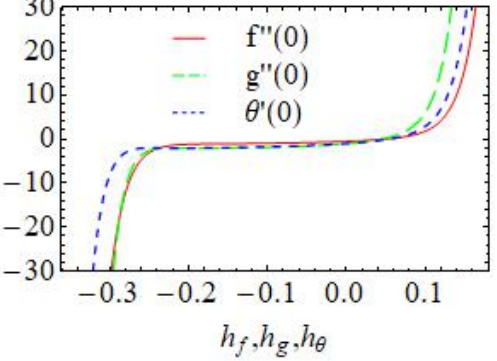
M = 0.1, Rd = Du = 0.2, and Sc = 0.6. Figure 2 clearly shows that the permitted range of profiles is tabulated in Table 3.